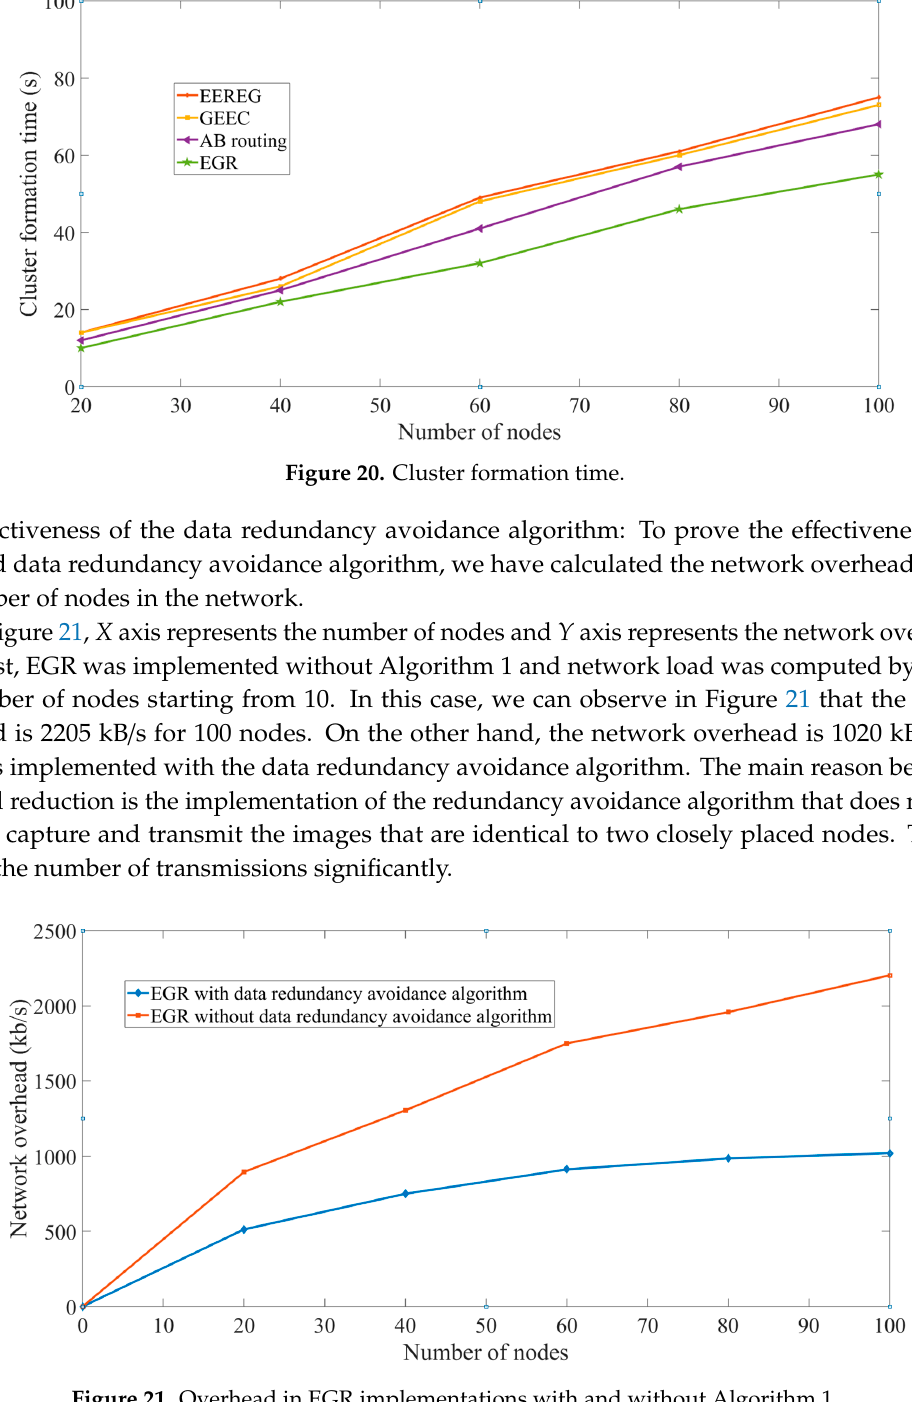
Figure 21. Overhead in EGR implementations with and without Algorithm 1.